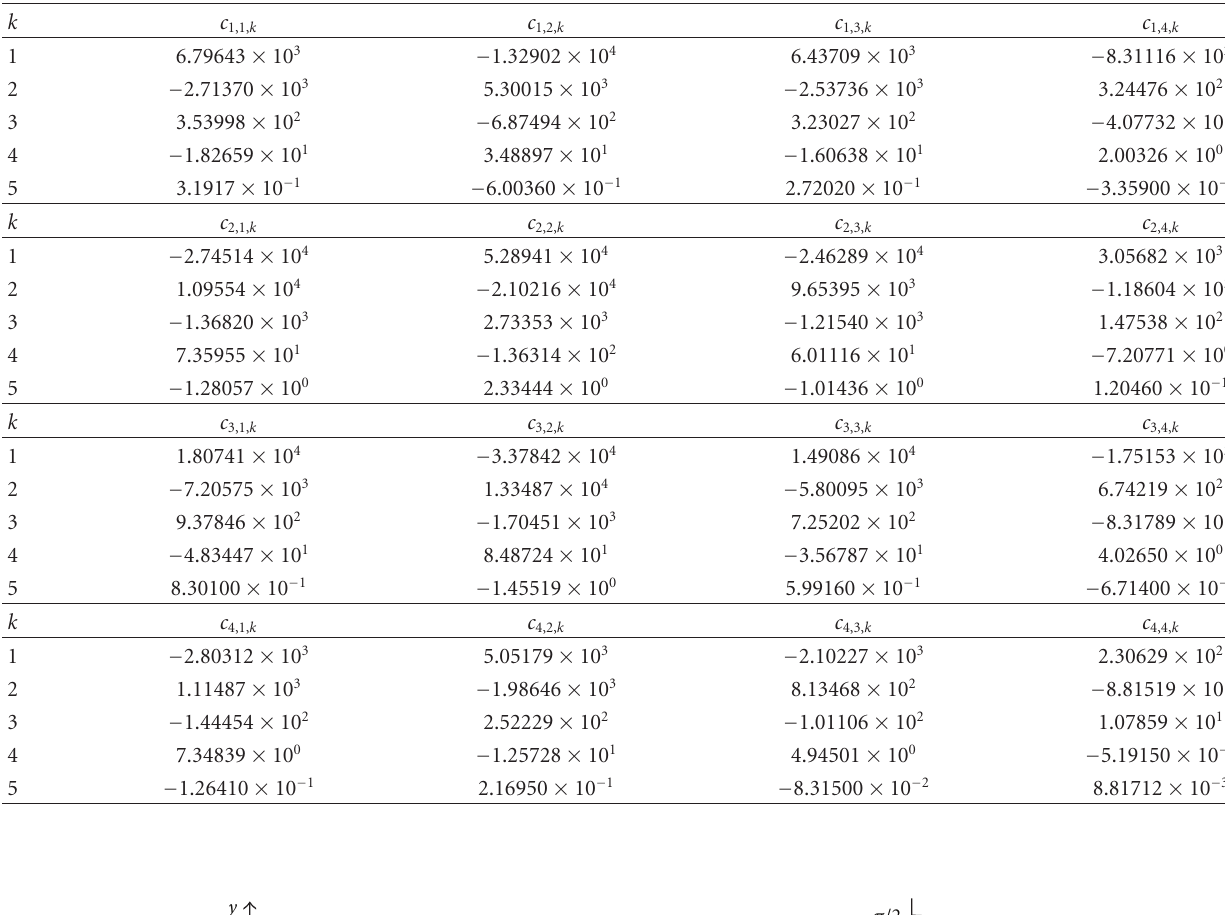
Table 1: The values of c i , j , k .